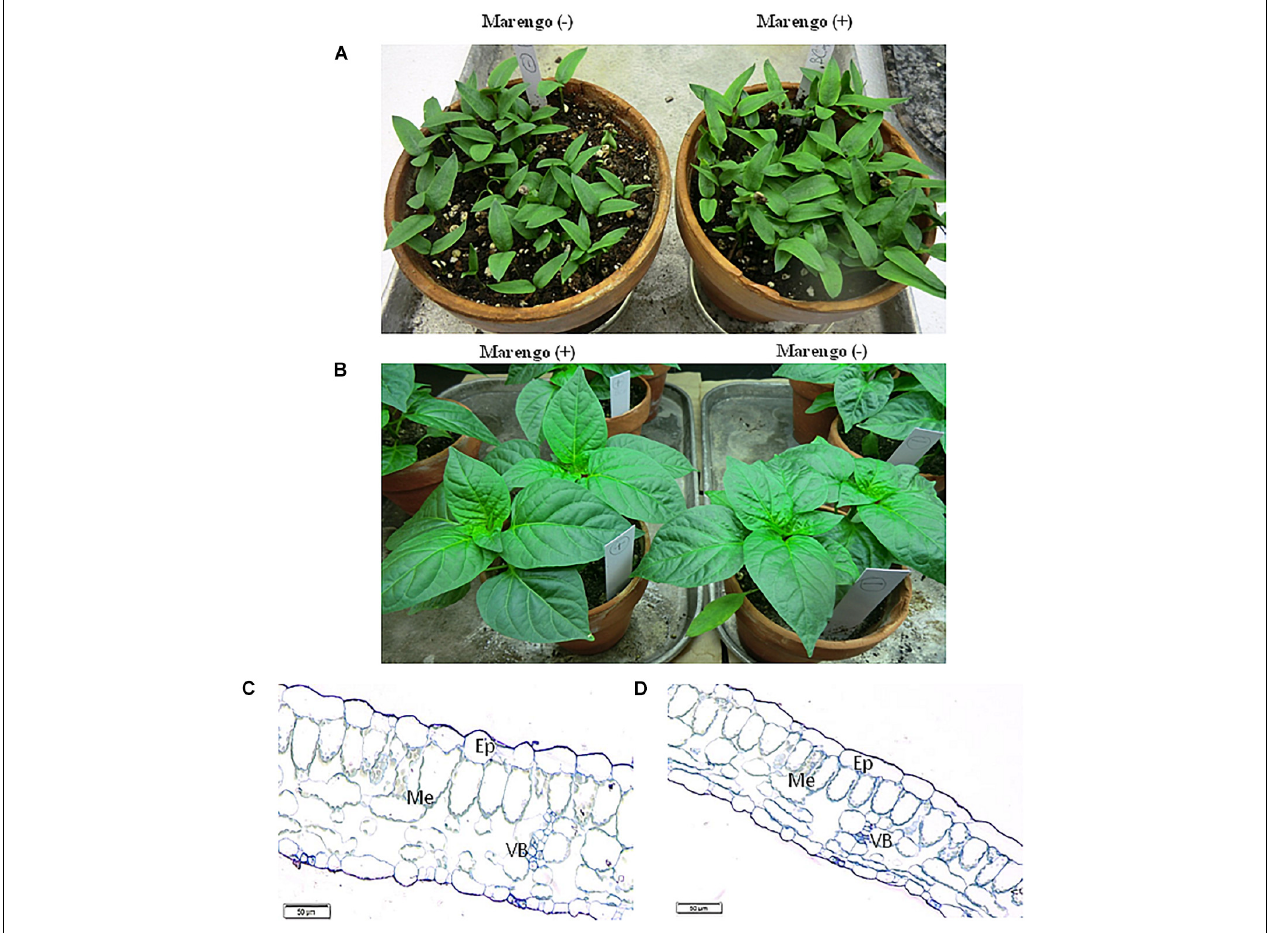
FIGURE 1 | Morphology and anatomy of two near-isogenic lines of bell pepper cv. Marengo, one infected with BPEV [Marengo (+)] and the other BPEV-free [Marengo ( − )]. (A) Seedlings, (B) Two- month-old plants. (C,D) Light microscopy of cross sections of tissues from two-month-old plants showing epidermis (Ep), Mesophyll (Me), and vascular bundles (VB). Bar 50 µ